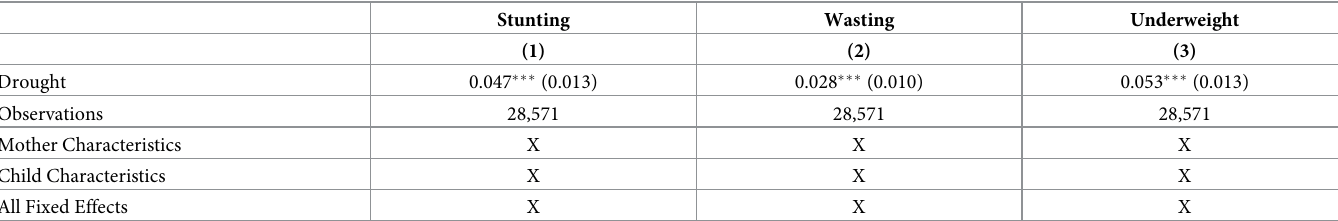
Table 5. Prenatal exposure to droughts and child health—Other outcomes